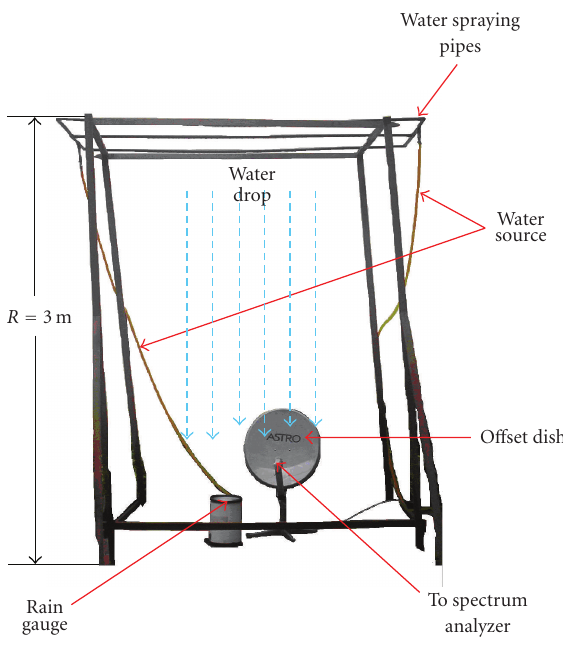
Figure 2: The outdoor experiment setup.